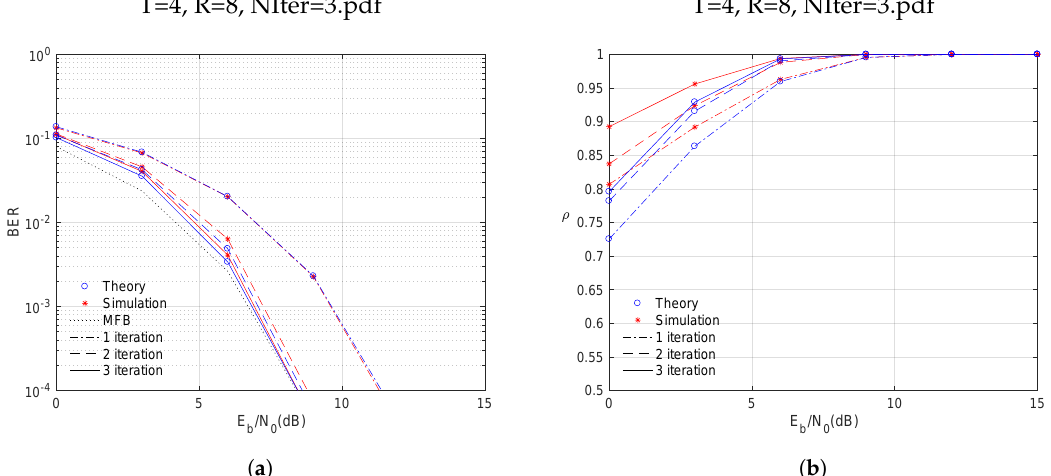
Figure 4. Theoretical/simulated BER performance and correlation factor for a receiver that combines IB-DFE and MRC in a MIMO system with 3 iterations. ( a ) BER performance. ( b ) Correlation factor ( ρ